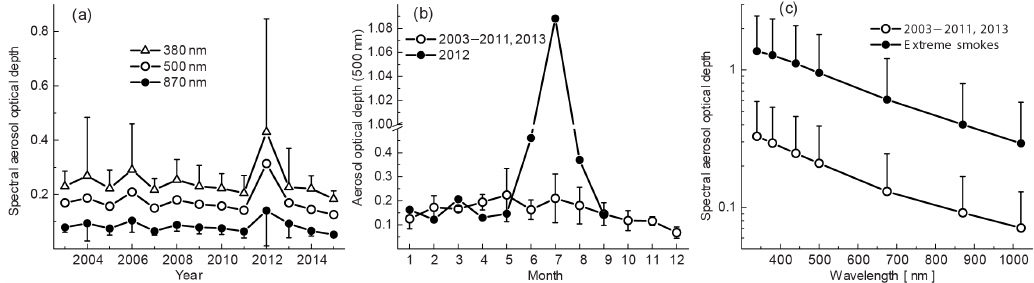
Figure 6. (a) Multi-year averages and standard deviations of spectral aerosol optical depth, (b) monthly averages of τ 500 in 2012 compared with the multi-year averages for the period of 2003–2011, 2013, and (c) average spectral AOD dependences in the period of 2012 extreme smoke compared to multi-year data in July (Tomsk, 2003–2011, 2013, combined data set of smoke and background conditions). One-sided error bars are used in order not to overburden the